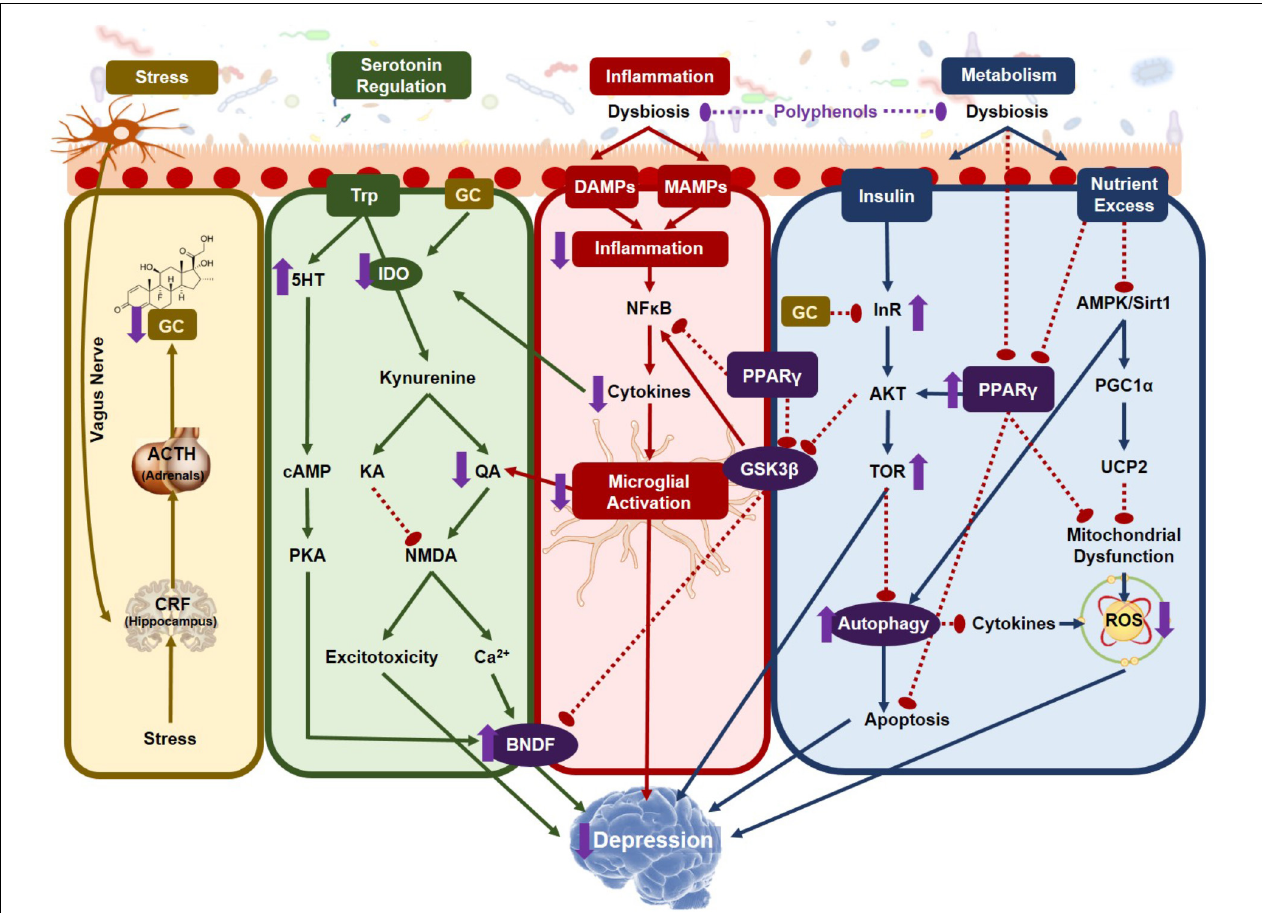
FIGURE 3 | Mechanisms connecting gastrointestinal dysbiosis with biological signature of depression. Depression is a multifaceted disorder with several coordinating pathologies, most which can be modulated by gut microbiota modifying agents including dietary polyphenols. The main gut-brain-axis mechanisms through which polyphenols and their microbial-derived metabolites can elicit a positive effect on depression are stress (yellow), serotonin regulation (green), inflammation (red) and metabolism (blue), effects which are shown as purple arrows. GC, glucocorticoids; ACTH, adrenocorticotropic hormone; CRH, corticotropin releasing hormone; 5HT, serotonin; Trp, tryptophan; IDO, indolamine-2,3-dioxygenase; KA, kynuric acid; QA, quinolinic acid; cAMP, cyclic adenosine monophosphate; PKA, protein kinase A; BDNF, brain derived neurotrophic factor; DAMPs, danger associated molecular patterns; MAMPs, microbe associated molecular patterns; PPAR γ , peroxisome proliferator activated receptor gamma; GSK β , glycogen synthase kinase 3 beta; InR, insulin receptor; AKT, Protein kinase B; AMPK, 5 (cid:48) AMP-activated protein kinase; PGC1, proliferator-activated receptor gamma coactivator; UCP2, uncoupling protein 2; ROS, reactive oxygen species.